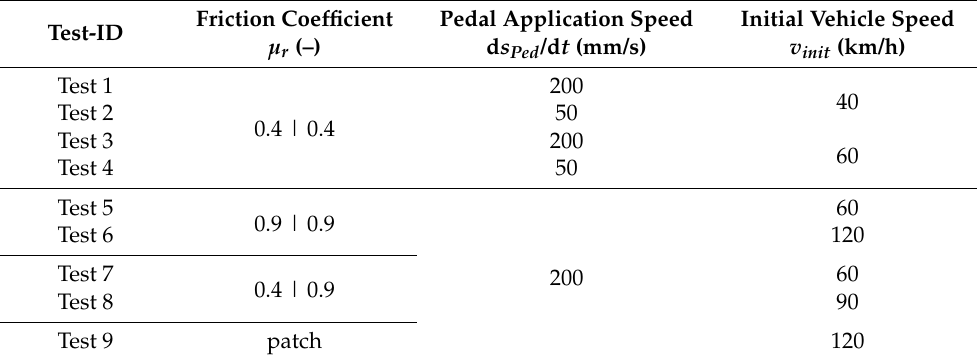
Table 2. Test case